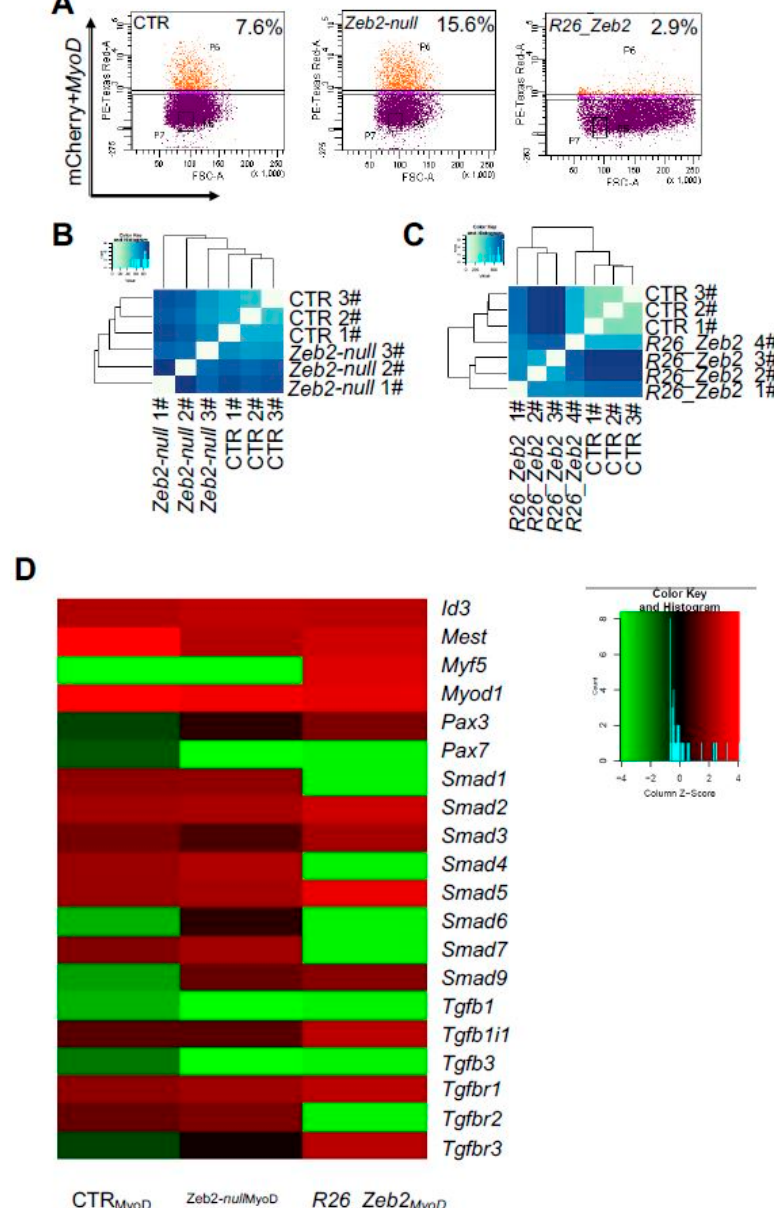
Figure 3. FACS-sorting and single cell RNAseq analysis of Zeb2-null and R_26 Zeb2 mESCs. ( A ) Quantification of mCherry / MyoD-positive cells by fluorescence-activated cell sorting. Unbiased clustering of CTR mESCs vs Zeb2-null ( B ) and R26_Zeb2 ( C ) mESCs analyzed by single RNA-seq. ( D ) The heatmap of expression levels of 20 myogenic regulatory genes from CTRL MyoD ( n = 3), Zeb2-null MyoD ( n = 3), and R26_Zeb2 MyoD ( n = 4) sorted cells analyzed by single